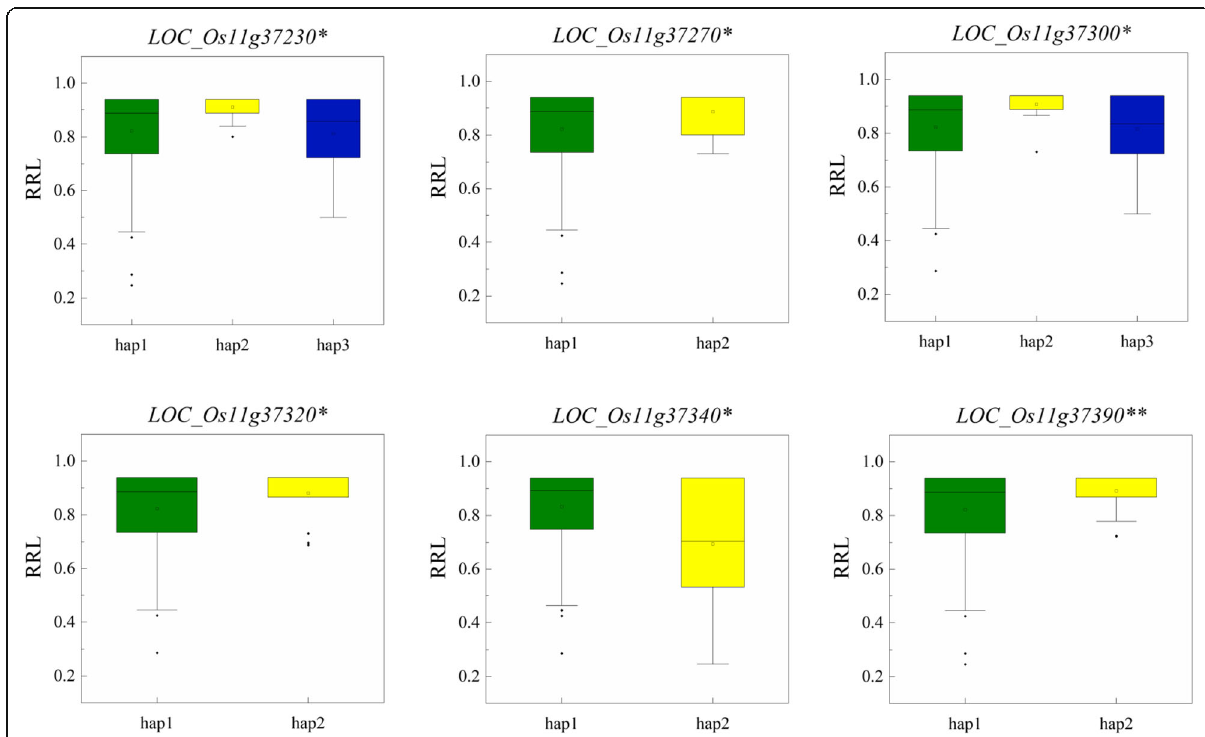
Fig. 4 Boxplots for RRL based on the haplotypes (Hap) for candidate genes; green, yellow and blue indicate the phenotypic result for hap1, hap2 and hap3, respectively (The * and ** suggest significance of ANOVA at P < 0.05 and P < 0.01, respectively)